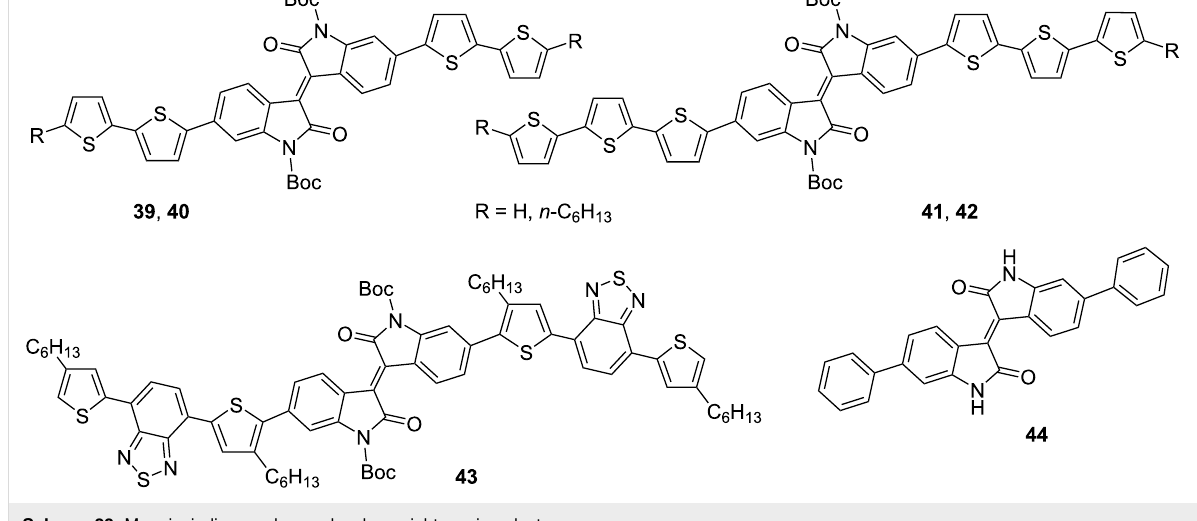
Scheme 23: Monoisoindigos as low-molecular-weight semiconductors.